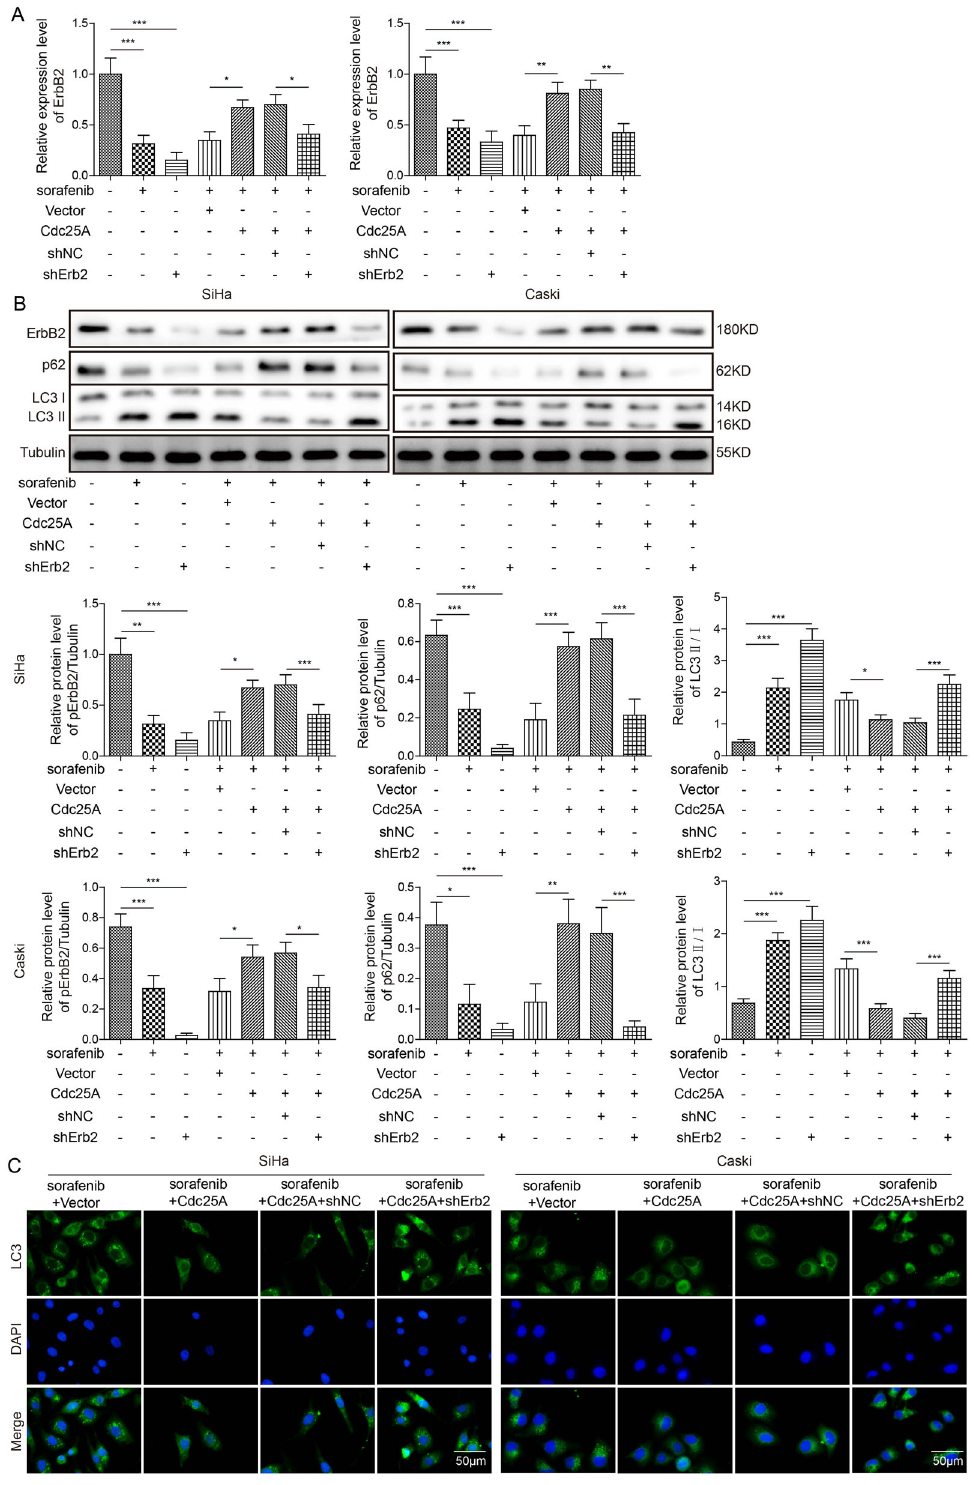
cancer cells (Fig. 7D). Similarly, intracellular levels of